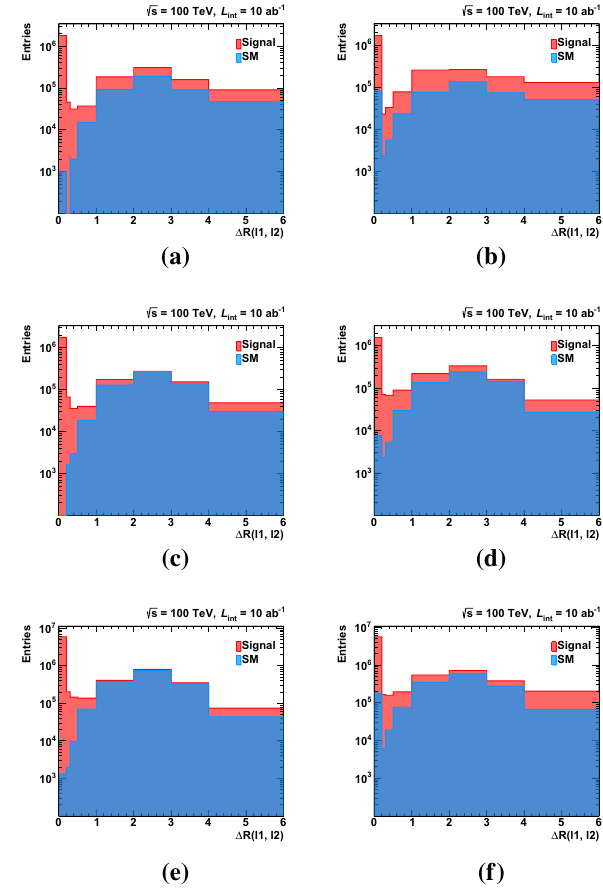
Fig. 6 (cid:13) R distributions between leptons of candidate Z boson pairs in the 4 e (a , b ), 4 μ ( c , d ) and 2 e 2 μ ( e , f ) channels. a , c , e for leading Z and b , d and f for sub-leading Z bosons